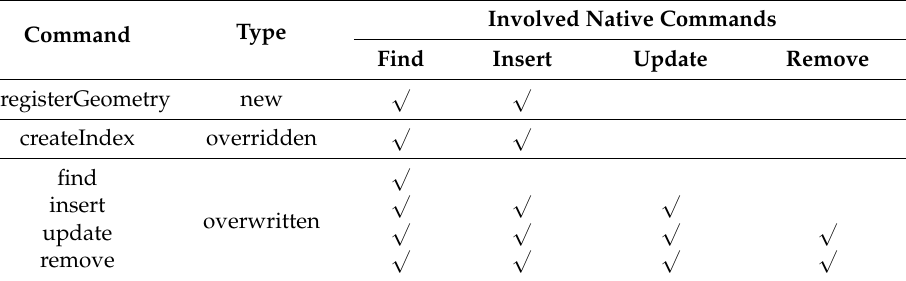
Table 2. Main commands supported by the R-tree module.